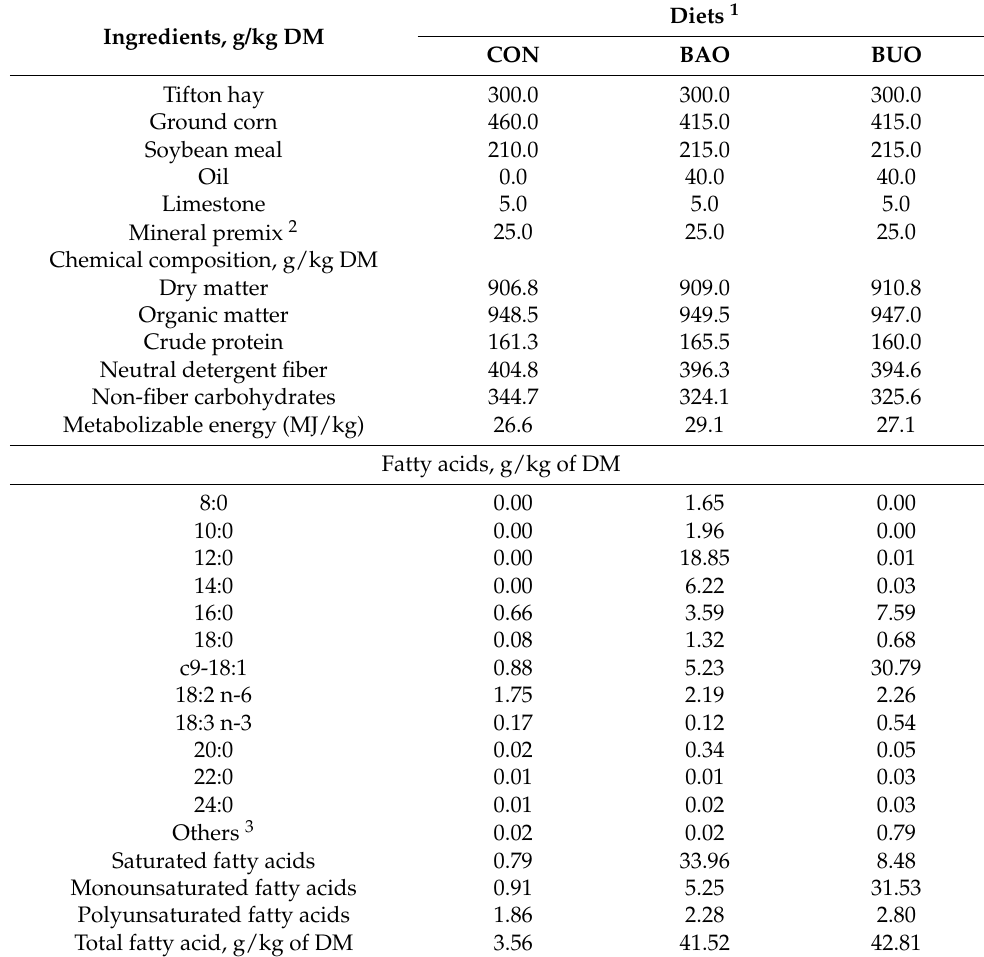
Table 1. Ingredients, chemical composition and fatty acid profile of experimental diets. Ingredients, g/kg